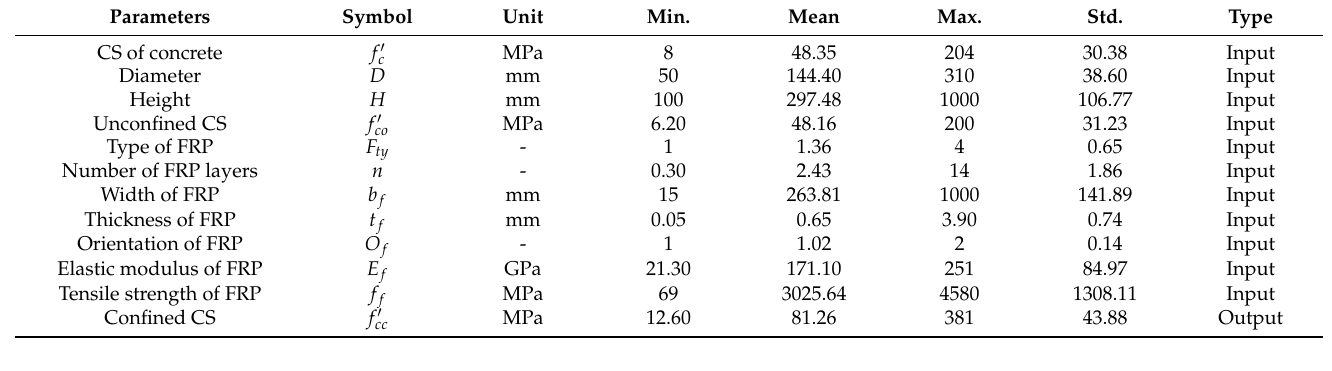
Table 2. Statistical indicators related to variables.